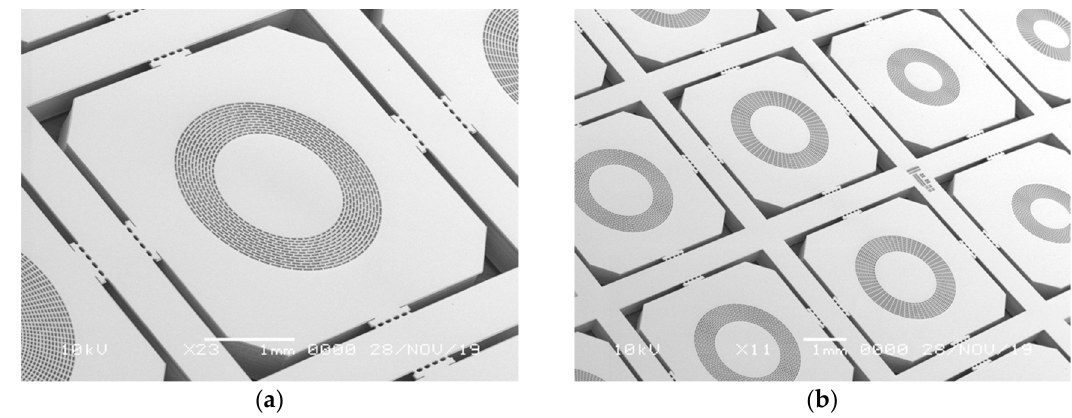
Figure 7. Process flow chart of out-of-plane membrane actuator.